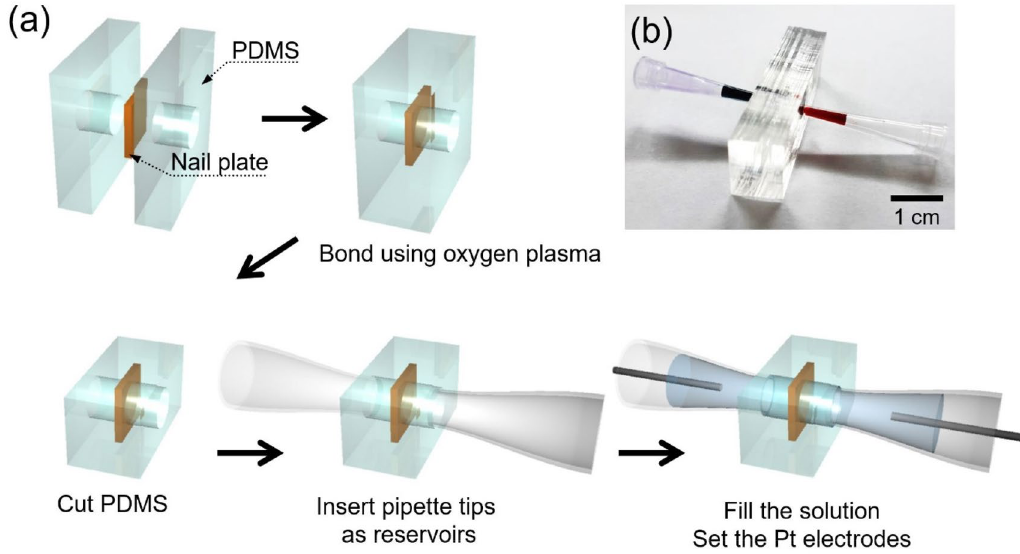
Figure 1. ( a ) The fabrication process of the nail device. ( b ) The photo of assembled nail